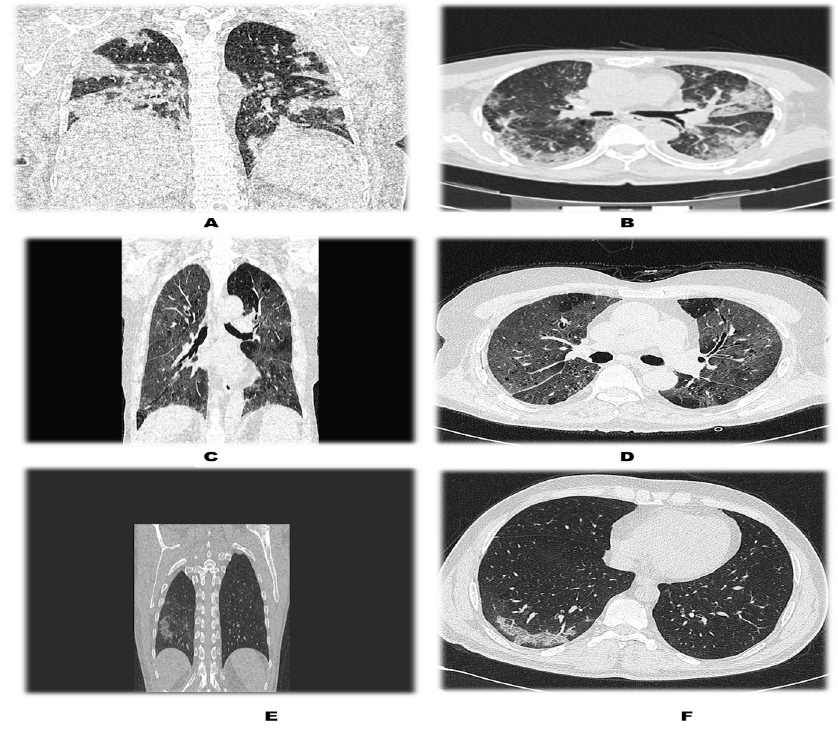
Figure 3. Axial and coronal cuts of patients with varying degrees of involvement of lung fields from severe to mild. ( A , B ) Coronal and axial cuts of a patient with severe involvement of the lung. ( C , D ) Coronal and axial cuts depicting moderate disease. ( E , F ) Mild involvement of lung field in a non-diabetic patient. The patient with severe lung involvement was the one who had underlying diabetes mellitus, clearly depicting severe involvement of lung fields.